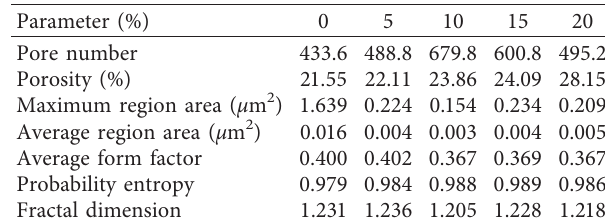
Table 2: Soil and pore parameters obtained by PCAS software.